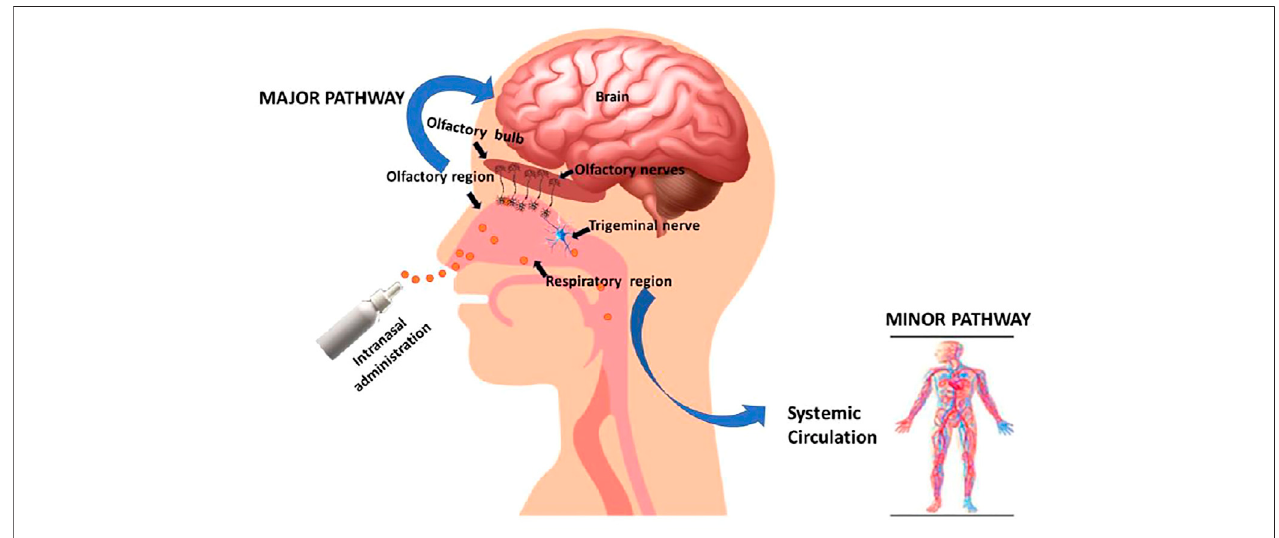
FIGURE 2 | Mechanism of drug delivery via the intranasal route of